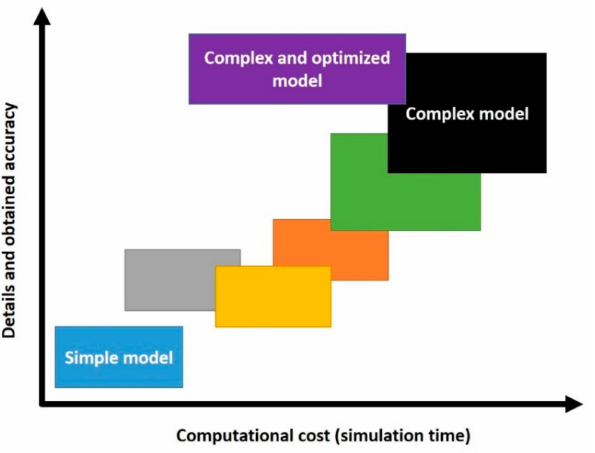
Figure 1. Trade-off between the complexity of the method and information content of